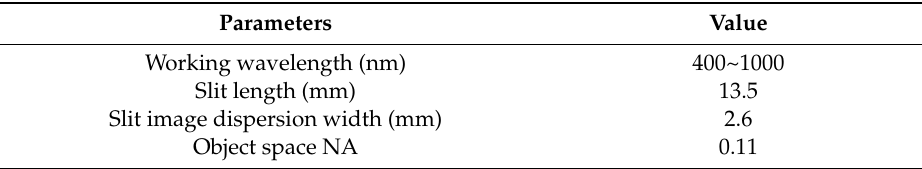
Table 5. O ff ner spectrometer parameter Table 5. Offner spectrometer parameter index.